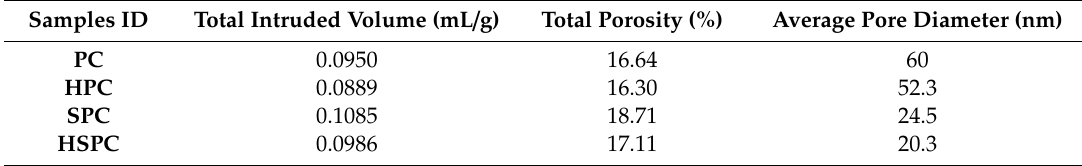
Table 5. Pore size distribution of